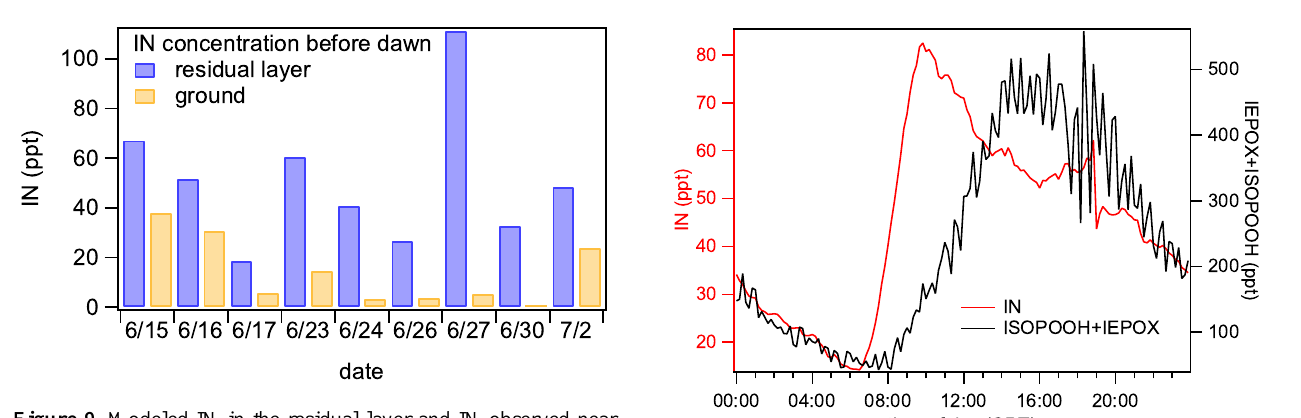
Figure 9. Modeled IN in the residual layer and IN observed near ground before dawn the next day. The model includes IN produc- tion from isoprene oxidation by NO 3 and IN consumption by re- action with OH, O 3 and NO 3 . The modeled IN may be biased, as concentration change caused by transport is not considered.